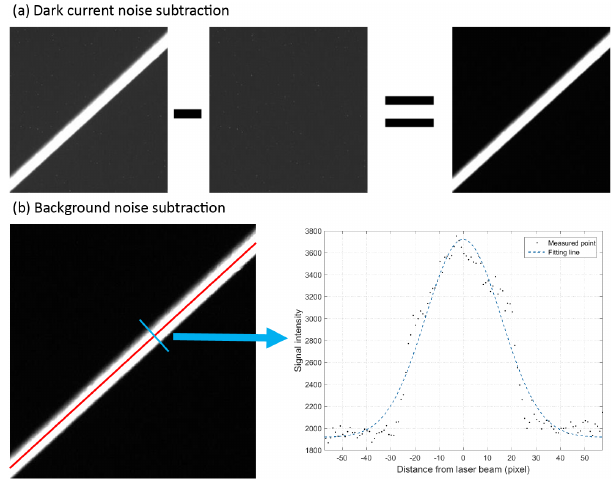
Figure 2. Noise subtraction of CCD-LADS: (a) dark current noise subtraction, (b) background noise subtraction.